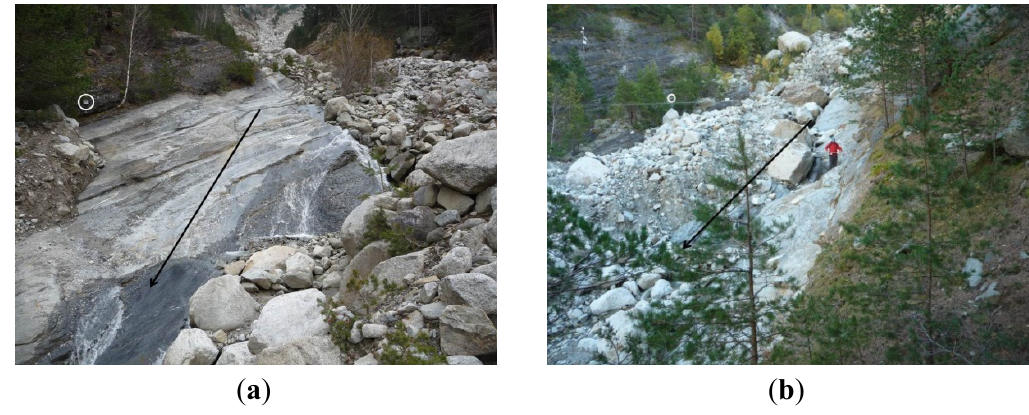
Figure 1. Factors affecting the ground vibration signal: characteristics of transmission medium between geophone and flow path. The transmission medium can be bedrock ( a ) or colluvium ( b ). The location of geophones is indicated by a circle; while the flow direction, is expressed by an